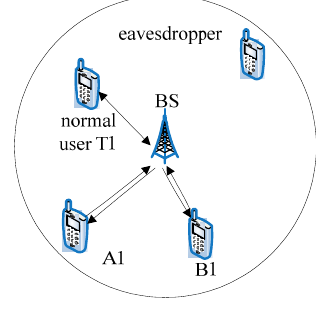
Figure 1. System model.